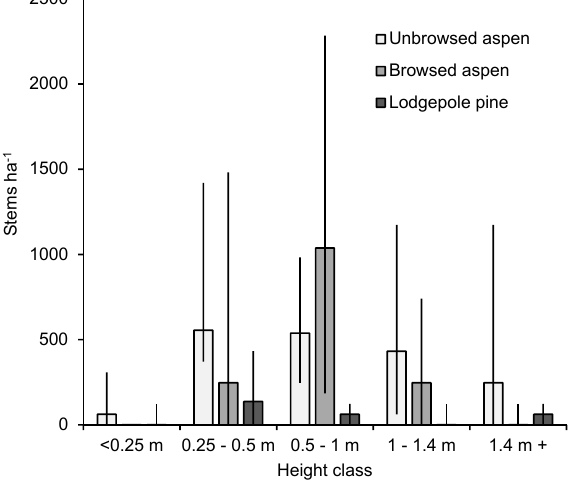
Figure 1. Understory stem density for unbrowsed aspen, browsed aspen, and lodgepole pine in the sampled stands. The bars show medians; the whiskers show the 1st–3rd quartile range. Data include all stems up to 2.5 cm in diameter at breast